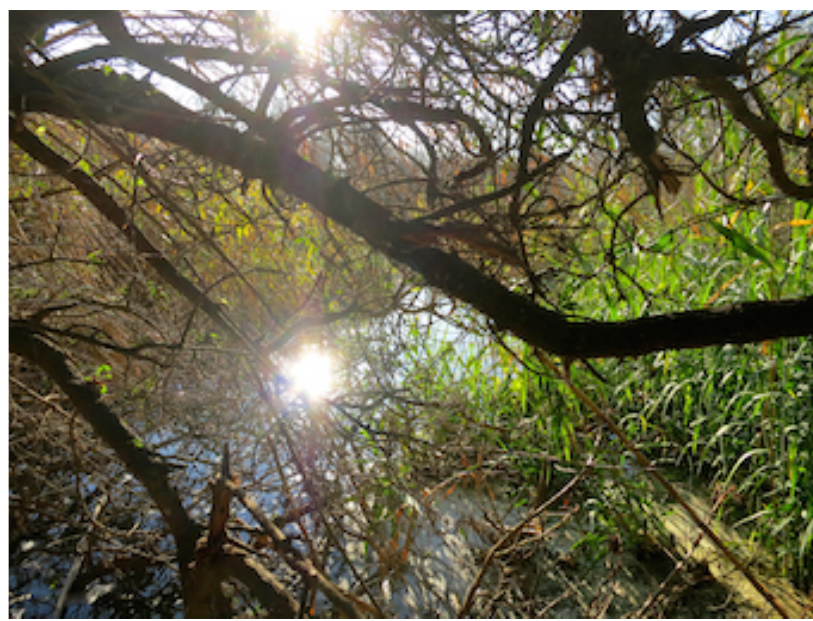
Figure 3. The view from Henry’s